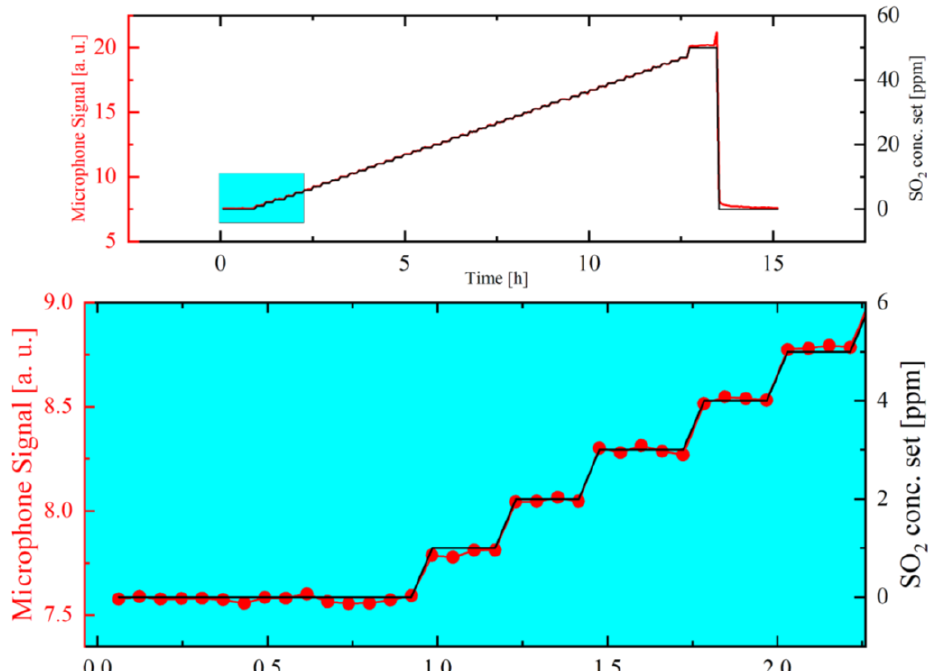
Figure 7. The microphone signal (red curve) in relation to the set SO 2 concentration (black curve), which is varied between 0 and 50 ppm using pre-calibrated mass flow controllers. Upper graph: The detected microphone signal in relation to the set SO 2 concentrations over a period of 15 h. Lower graph: zoom graph of the microphone signal at the first five concentration variations resembling the set SO 2 concentrations 0 up to 5 ppm.